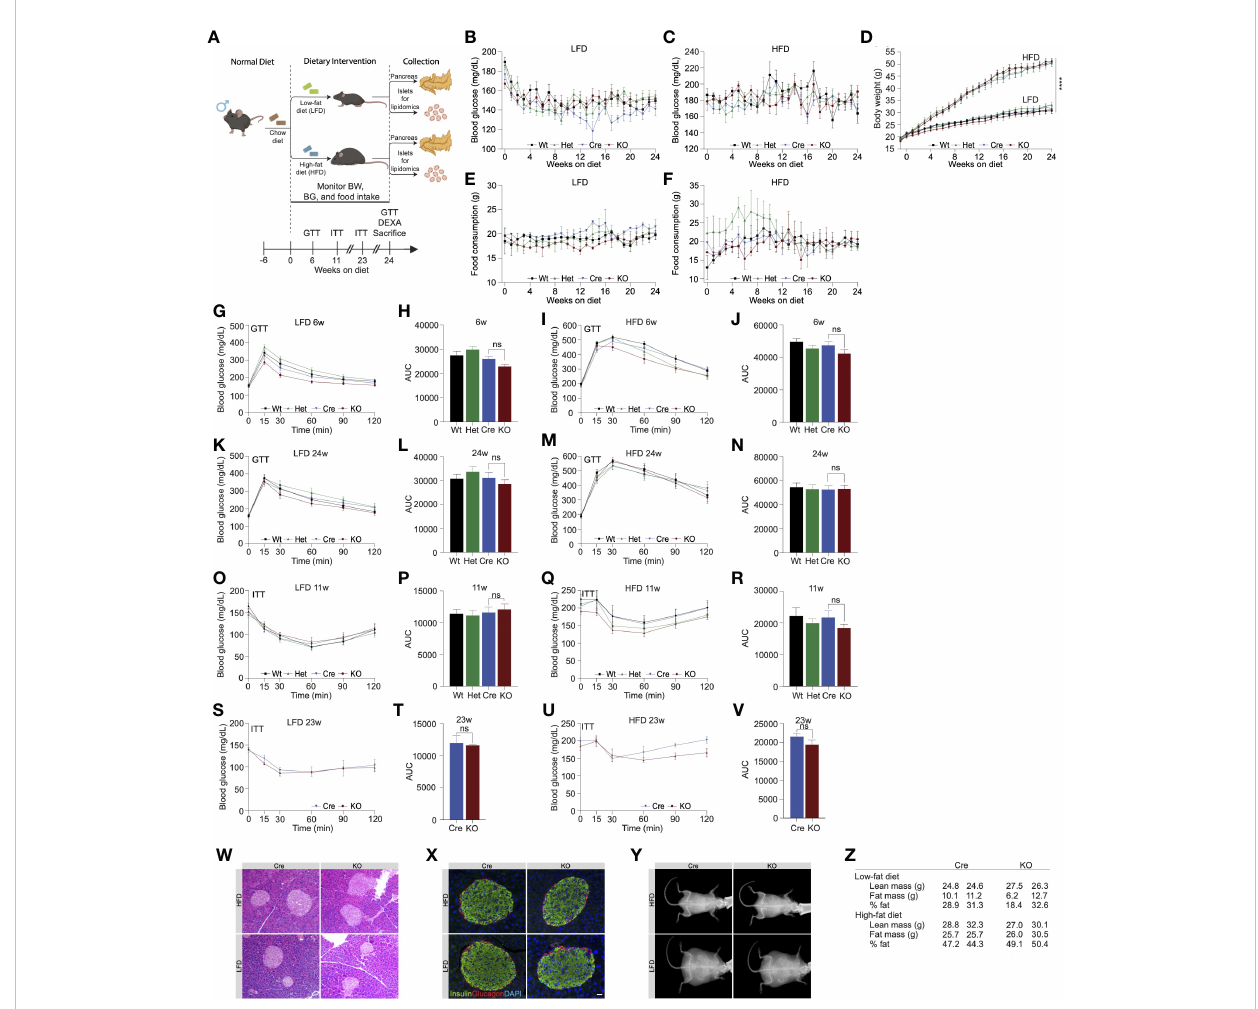
FIGURE 2 High fat diet feeding in Ormdl3 b -/- mice does not impact b -cell function or glucose homeostasis. (A) Schematic representation of mouse monitoring and study design. (B) Weekly fasting blood glucose assessment of Wt, Het, Cre, and KO mice under LFD and (C) HFD conditions (n=9/group; two- way ANOVA with Tukey ’ s post-hoc test). (D) Weekly body weight measurements in LFD and HFD-fed Wt, Het, Cre, and KO mice (n=9/group; Two- way ANOVA with Tukey ’ s post-hoc test). (E) Weekly food consumption in Wt, Het, Cre, and KO LFD and (F) HFD-fed mice (grams of food eaten/ mouse/week; Two-way ANOVA with Tukey ’ s post-hoc test). (G-N) Glucose tolerance and area under the curve (AUC) calculations for LFD and HFD- fed male Wt, Het, Cre, and KO mice. (G) Glucose tolerance and (H) total AUC of 6-weeks-on-diet LFD-fed mice (n=9/group; Two- and one-way ANOVA with Tukey ’ s post-hoc test, respectively). (I) Glucose tolerance and (J) total AUC of 6-weeks-on-diet HFD-fed mice (n=9/group; Two- and one-way ANOVA with Tukey ’ s post-hoc test, respectively). (K) Glucose tolerance and (L) total AUC of 24-weeks-on-diet LFD-fed mice (n=9/group; Two- and one-way ANOVA with Tukey ’ s post-hoc test, respectively). (M) Glucose tolerance and (N) total AUC of 24-weeks-on-diet HFD-fed mice (n=9/group; Two- and one-way ANOVA with Tukey ’ s post-hoc test, respectively). (O-V) Insulin tolerance and AUC calculations for LFD and HFD-fed male Wt, Het, Cre, and KO mice. (O) Insulin tolerance and (P) total AUC of 11-weeks-on-diet LFD-fed mice (n=9/group; Two- and one-way ANOVA with Tukey ’ s post-hoc test, respectively). (Q) Insulin tolerance and (R) total AUC of 11-weeks-on-diet HFD-fed mice (n=9/group; Two- and one-way ANOVA with Tukey ’ s post-hoc test, respectively). (S) Insulin tolerance and (T) total AUC of 23-weeks-on-diet LFD-fed mice (n=9/group; Two- and one-way ANOVA with Tukey ’ s post-hoc test, respectively). (U) Insulin tolerance and (V) total AUC of 23-weeks-on-diet HFD-fed mice (n=9/group; Two- and one-way ANOVA with Tukey ’ s post-hoc test, respectively). (W) Representative images of H&E staining of 24-weeks-on-diet male LFD and HFD-fed Cre and KO mice. (X) Representative images from co-staining for insulin and glucagon in pancreatic sections from 24-weeks-on-diet LFD and HFD-fed male Cre and KO mice. (Y) Representative images of DEXA assessment in 24-weeks-on-diet LFD and HFD-fed male Cre and KO mice. (Z) Table of DEXA assessment of lean mass and fat mass (n=2/group). Data are presented as means ± SEM. One- and two-way ANOVA with Tukey ’ s post-hoc test (****p<0.0001) are applied where indicated. BW, body weight; BG, blood glucose; GTT, glucose tolerance test; ITT, insulin tolerance test; DEXA, dual-energy x-ray absorptiometry; Wt, wild type; Het, Ormdl3 b +/- heterozygous knockout; Cre, mouse expressing Ins1 tm1.1(cre)Thor/J with wild type Ormdl3 alleles; KO, Ormdl3 b -/- homozygous knockout; LFD, low fat diet; HFD, high fat diet; AUC, area under the curve; DAPI, 4 ′ ,6- diamidino-2-phenylindole; w, weeks; ns, not signi fi cant; ANOVA, analysis of variance. Scale bars are 20